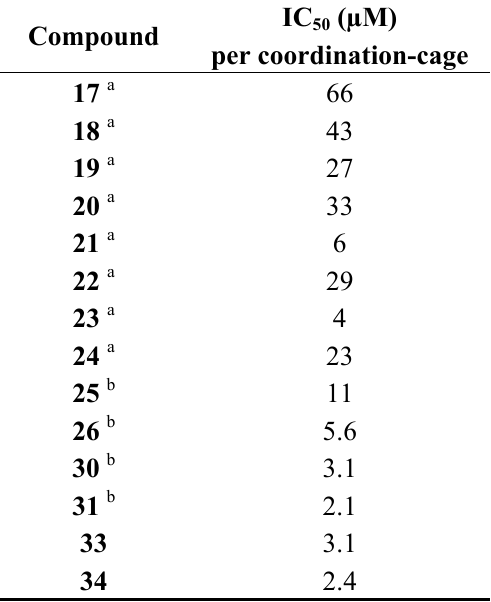
Table 2. IC of the ruthenium coordination-cage conjugates, 17 – 26 , 30 – 31 and 33 – 34 , on 50 A2780 human ovarian cancer cells after 72 h of